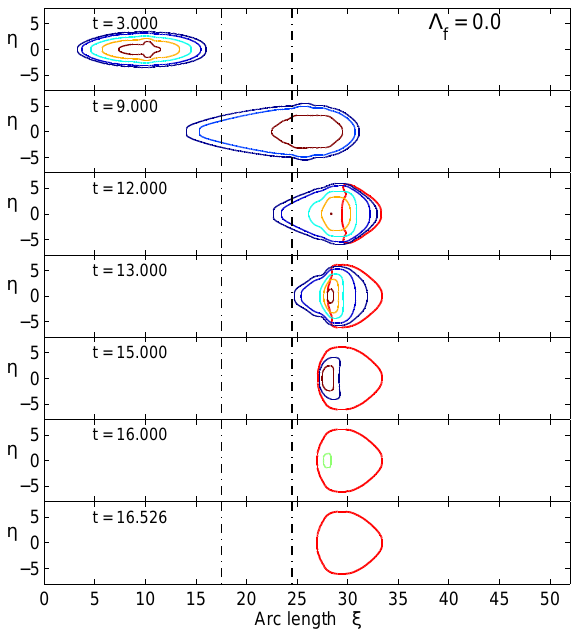
Fig. 5. Contour plots of the flowing mass and the evolution of the deposition heap, where Λ f =0 . 2 with the deposition procedure be- ing adopted in the computation.